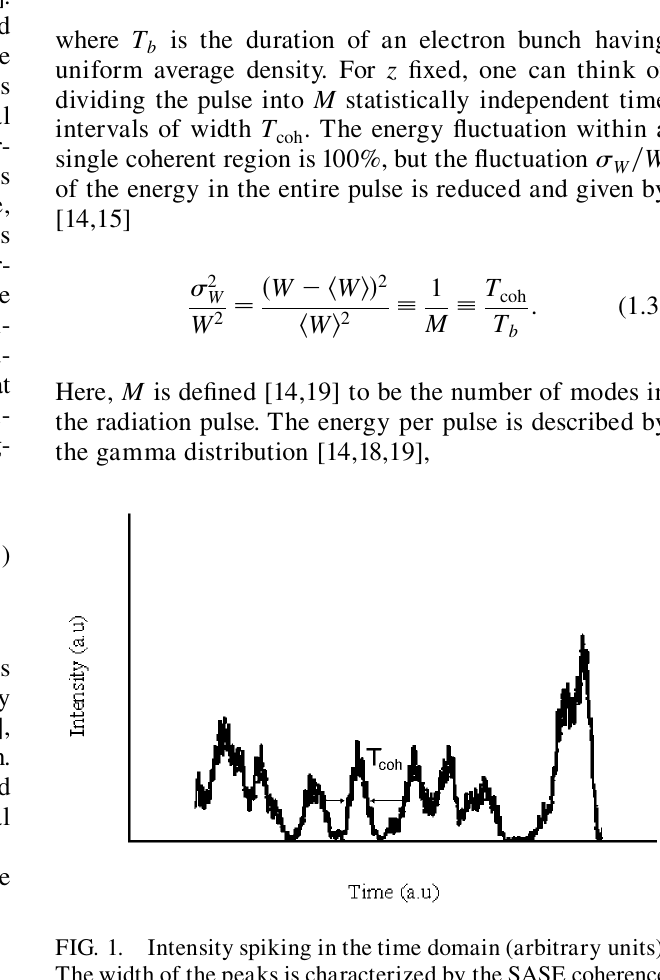
.*Permanent address: Brookhaven National Laboratory, Upton, NY